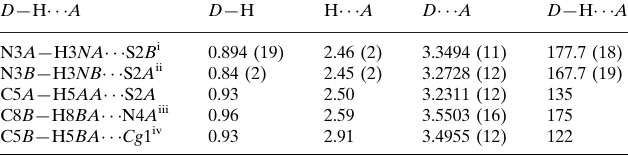
Data collection Bruker APEXII DUO CCD area- detector diffractometer Absorption correction: multi-scan ( SADABS ; Bruker, 2009) T min = 0.845, T max = 0.896 Refinement R [ F 2 > 2 (cid:2) ( F 2 )] = 0.040 wR ( F 2 ) = 0.114 S = 1.06 8745 reflections 288 parameters 1 restraint